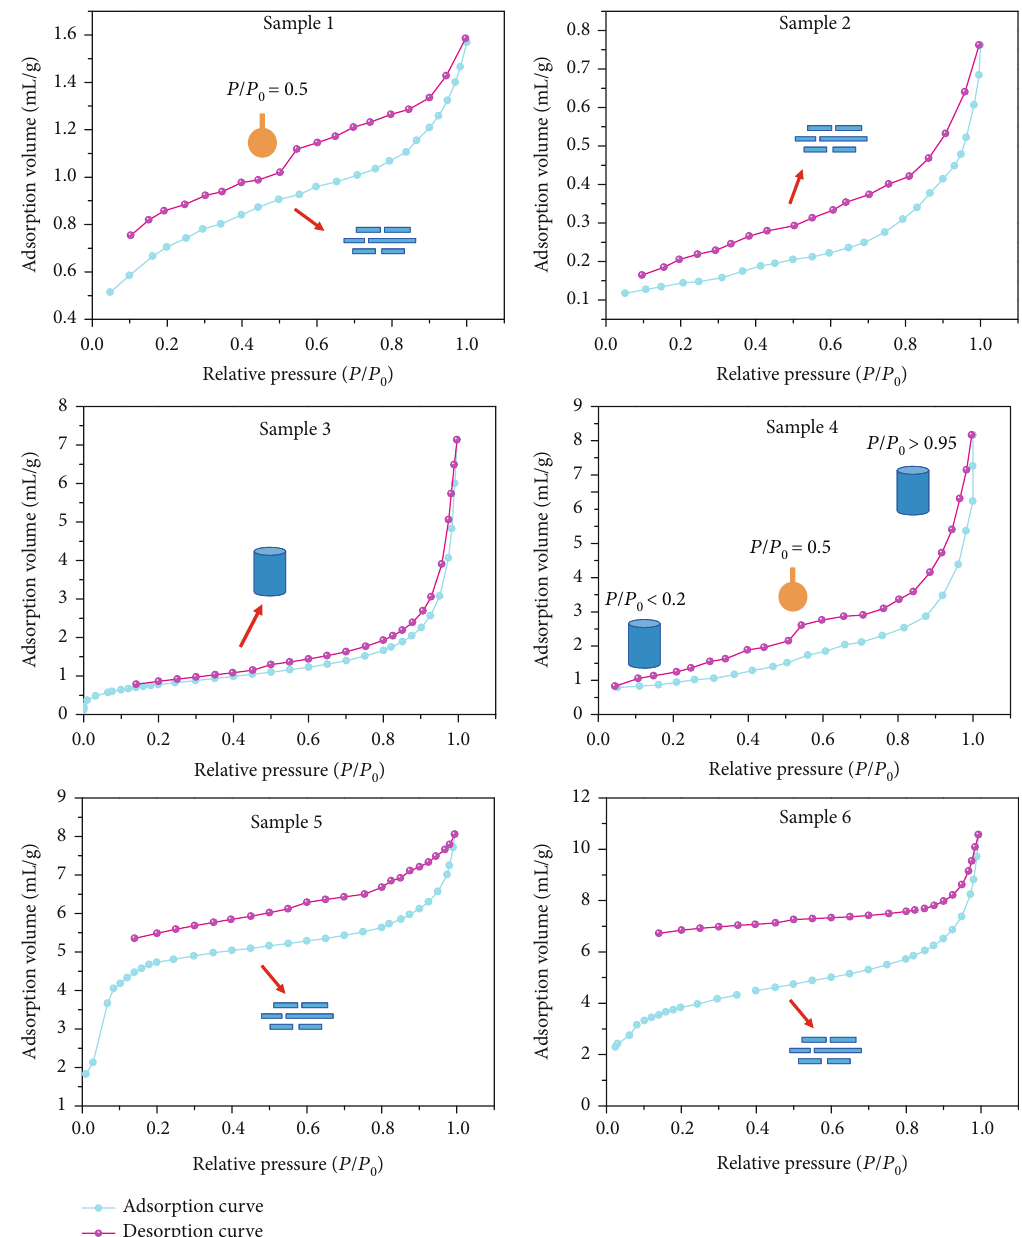
Figure 10: Nitrogen adsorption isotherms of experimental coal